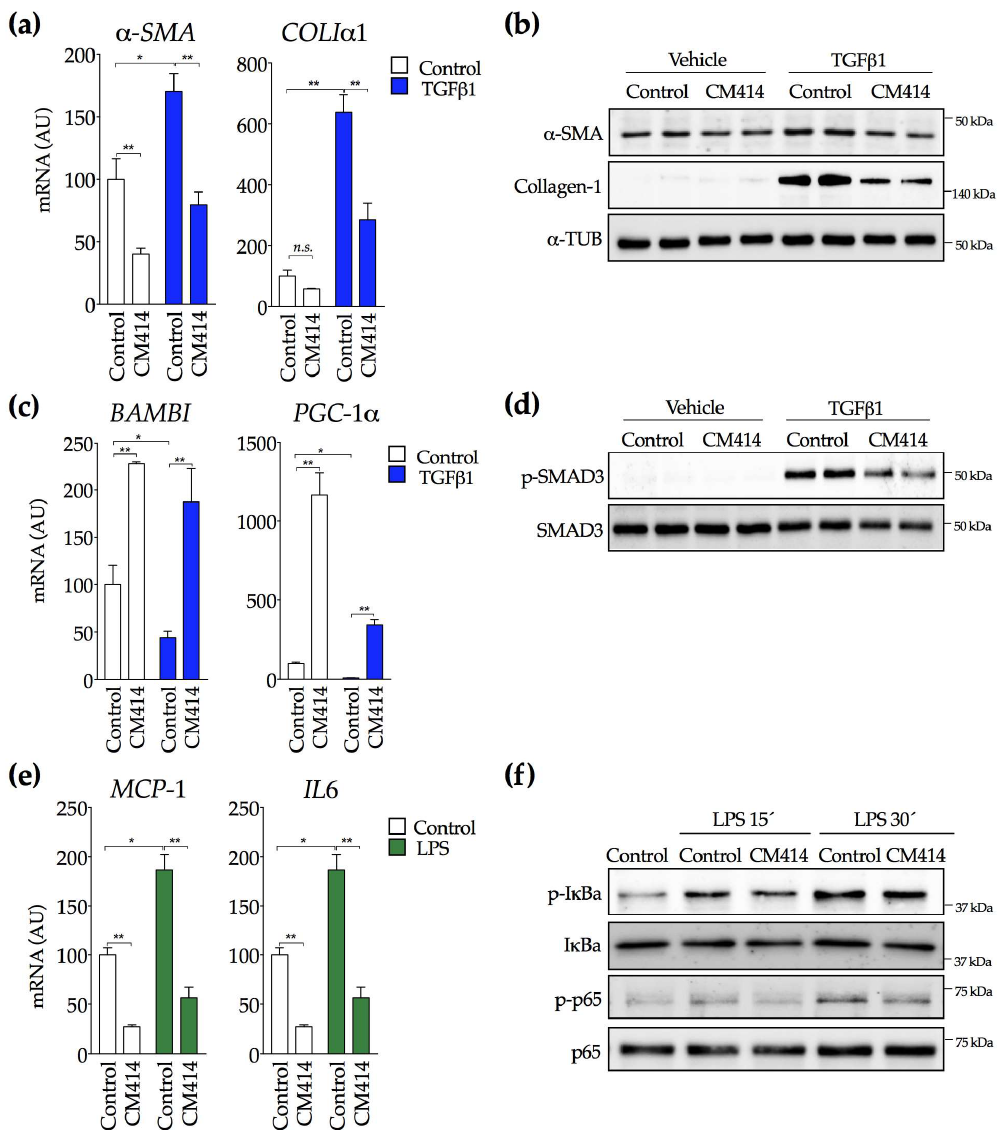
Figure7. E ff ectofCM414onTGF β 1andlipopolysaccharide(LPS)-mediatedactivationofcholangiocytes. Figure 7. Effect of CM414 on TGFβ1 and lipopolysaccharide (LPS)-mediated activation of ( a ) qPCR analysis of a-SMA and collagen I α 1 ( COLI α 1) expression in H69 cells treated with CM414 cholangiocytes. ( a ) qPCR analysis of a-SMA and collagen Iα1 ( COLIα 1) expression in H69 cells treated (5 µ M) for 24 h and then stimulated with TGF β 1 (5 ng / mL) for another 24 h. ( b ) immunoblot analyses with CM414 (5 μM) for 24 h and then stimulated with TGFβ1 (5 ng/mL) for another 24 h. ( b ) of α -SMA, collagen-1 and α -tubulin protein levels in H69 cells treated as indicated above. ( c ) qPCR immunoblot analyses of α-SMA, collagen-1 and α-tubulin protein levels in H69 cells treated as indicated above. ( c ) qPCR analyses of activin membrane-bound inhibitor ( BAMBI ) and PGC-1α analyses of activin membrane-bound inhibitor ( BAMBI ) and PGC-1 α expression in H69 cells treated as expression in H69 cells treated as indicated above. ( d ) immunoblot analyses of phospho-SMAD3 and indicated above. ( d ) immunoblot analyses of phospho-SMAD3 and SMAD3 protein levels in H69 cells SMAD3 protein levels in H69 cells treated as indicated above. ( e ) qPCR analysis of MCP1 and IL6 treated as indicated above. ( e ) qPCR analysis of MCP1 and IL6 mRNA expression in H69 cells treated mRNA expression in H69 cells treated with CM414 (5 μM) for 24 h and then stimulated with LPS (1 with CM414 (5 µ M) for 24 h and then stimulated with LPS (1 µ g / mL) for another 24 h. ( f ) immunoblot μg/mL) for another 24 h. ( f ) immunoblot analyses of phospho-IκBa, IκBa, phospho-p65 and p65 analyses of phospho-I κ Ba, I κ Ba, phospho-p65 and p65 protein levels in H69 cells treated with CM414 protein levels in H69 cells treated with CM414 (5 μM) for 24h and then stimulated with LPS (1 μg/mL (5 µ M) for 24h and then stimulated with LPS (1 µ g / mL for 15 min and 30 min. Representative blots of for 15 min and 30 min. Representative blots of three experiments performed in duplicate are shown. three experiments performed in duplicate are shown. * p < 0.05. ** p < * p < 0.05. ** p < 0.01.